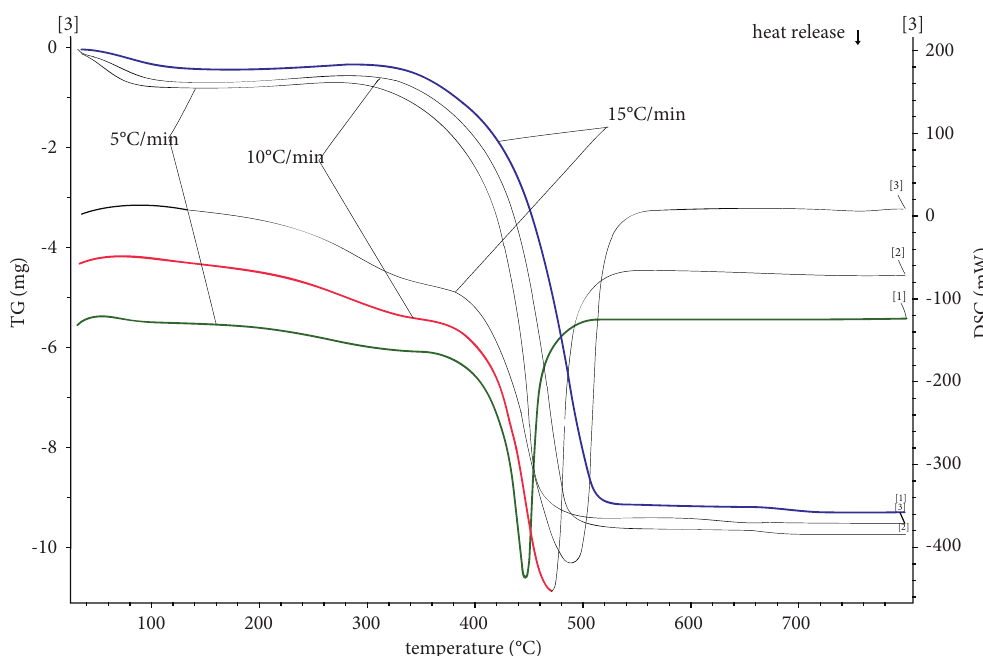
Figure 7: TG/DSC results for the Bulianta 12# raw coal sample at heating rates of 5-10-15 ° C/min in air.